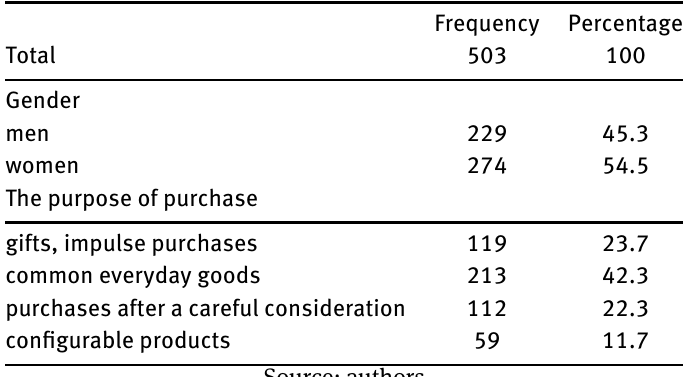
Table 1: Structure of survey respondents.